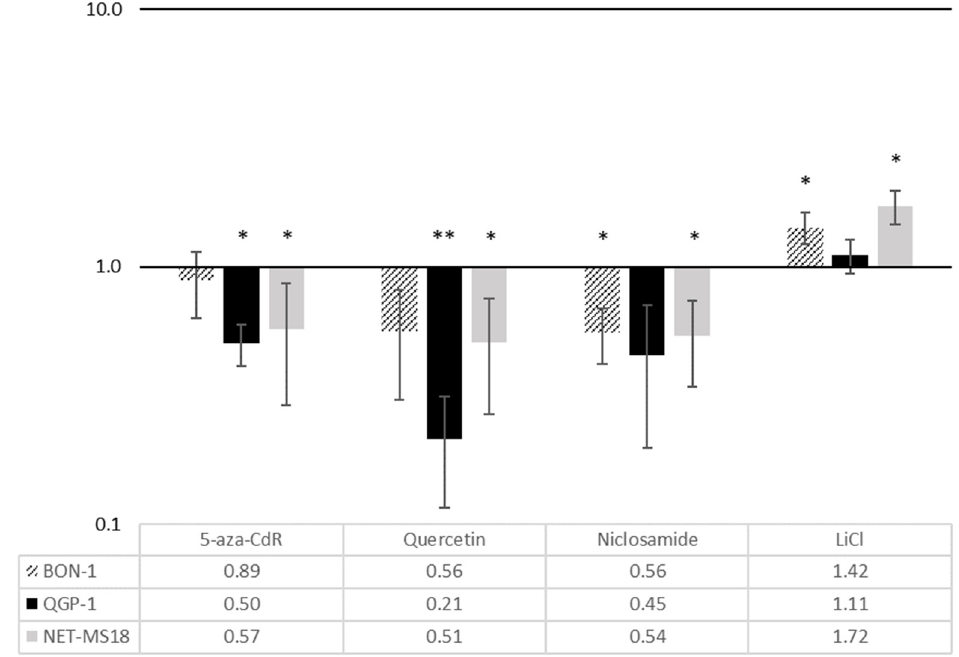
Figure 2. mRNA expression of CXCR4 after treatment with Wnt modulators in BON-1, QGP-1, and MS-18 cells (logarithmic scale). The data are shown as percentages of untreated control cells. The expression levels were normalized to housekeeping gene GAPDH ( mean ± SD; n = 6 experimental repeats; * p < 0.05, ** p < 0.01).